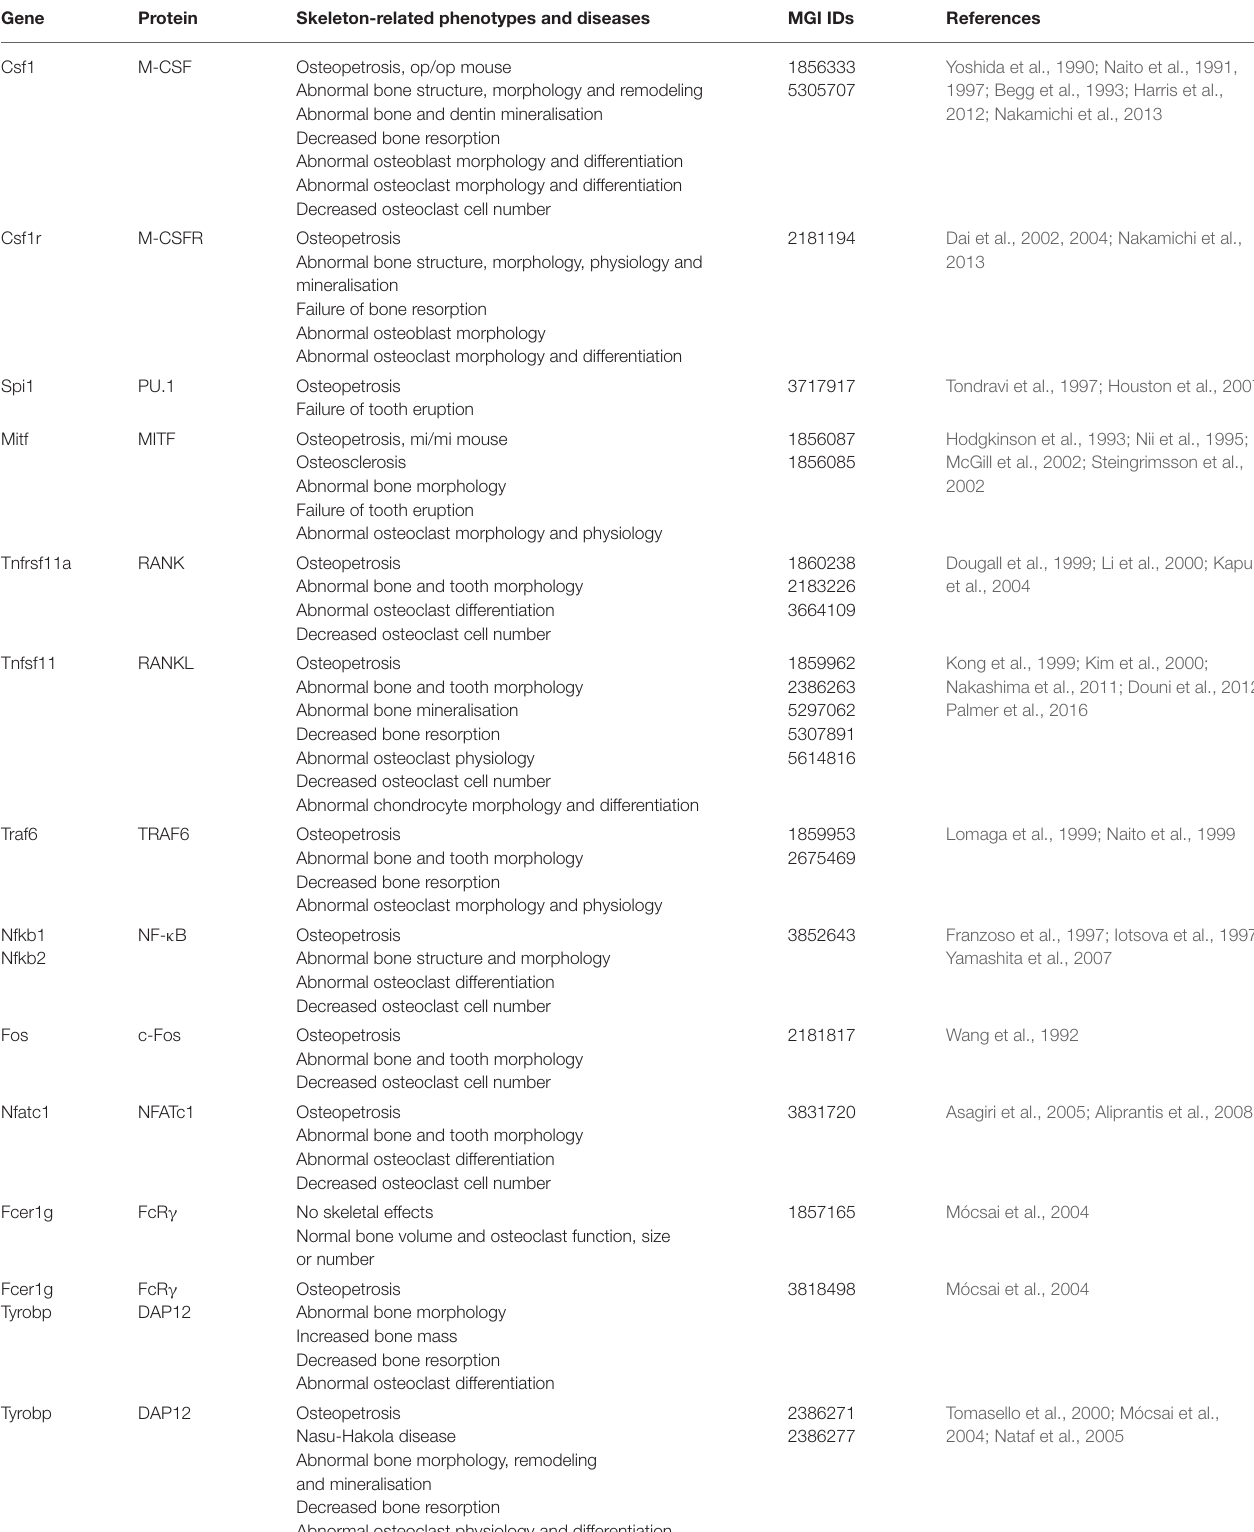
TABLE 1 | Summary of skeleton-related phenotypes in knockout mice for genes involved in osteoclast differentiation in the order in which they are discussed in the text.